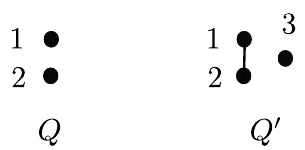
Figure 7. The quivers Q and Q 0 related by